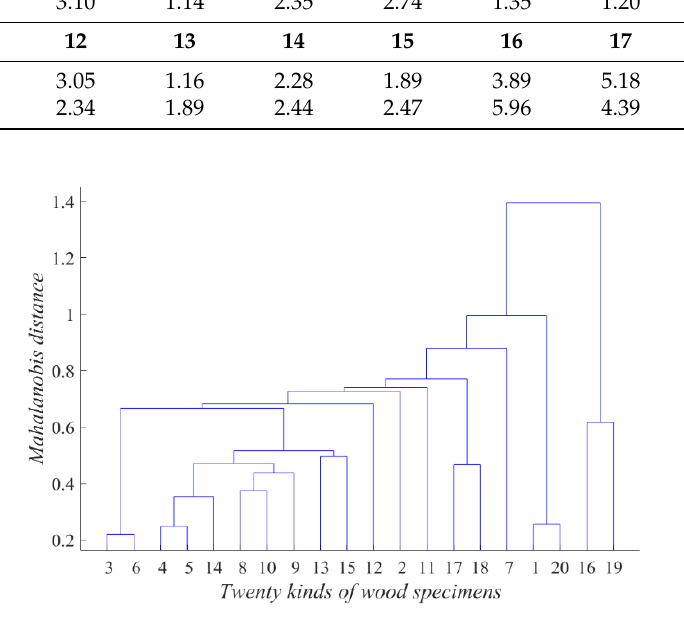
Figure 4. Cluster analysis of ∆ E ∗ before the chromatic aberration